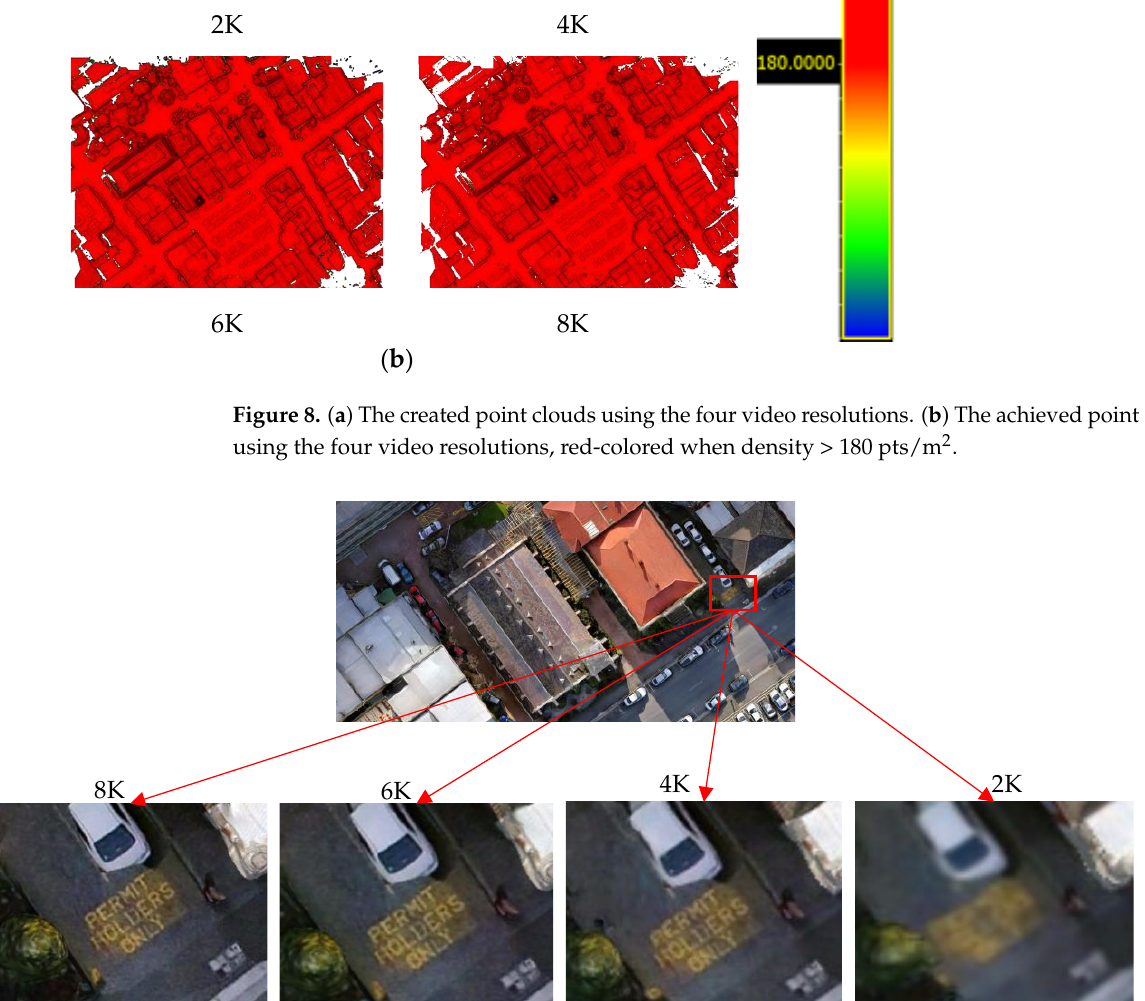
Table 1. Orthomosaic resolution and pixel size of the first experiment.